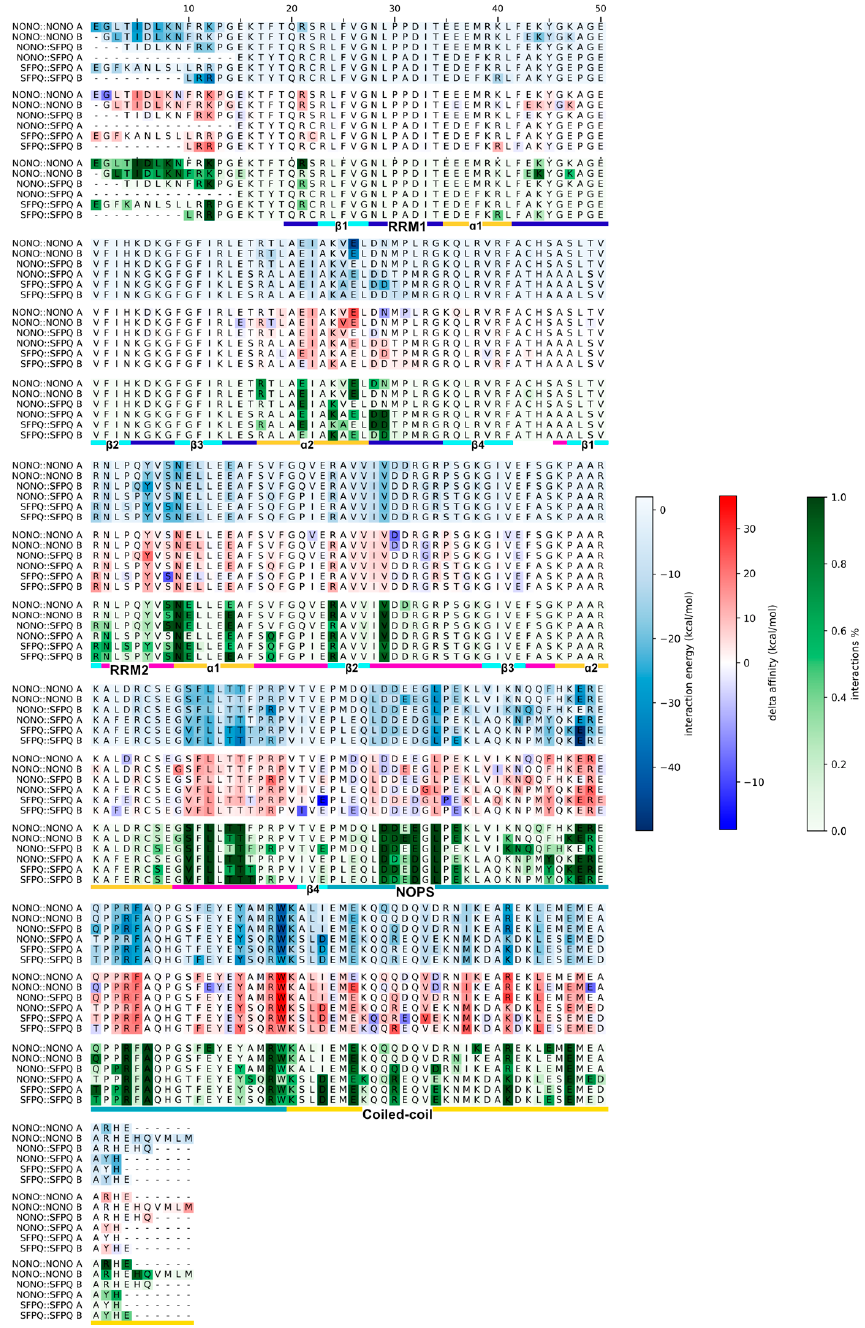
Figure 4. Comparison of MD interactions, single-point interaction energies, and alanine scan delta affinity. Time-persistence of hydrogen bonds, salt bridges, and pi–pi and pi–cation interactions was measured along MD trajectories, as a fraction of the simulation time. Single-point energy contributions and alanine scan delta affinity were computed on the MD medoids. The three complementary methodologies highlight the key residues responsible for inter-chain protein::protein interactions. First, we identified persistent backbone-to-backbone hydrogen bond interactions within the N-terminal loops for only the NONO::NONO homodimer (Figure 5a), in accor- dance with the antiparallel β -clasp interactions, as described by Knott et al.